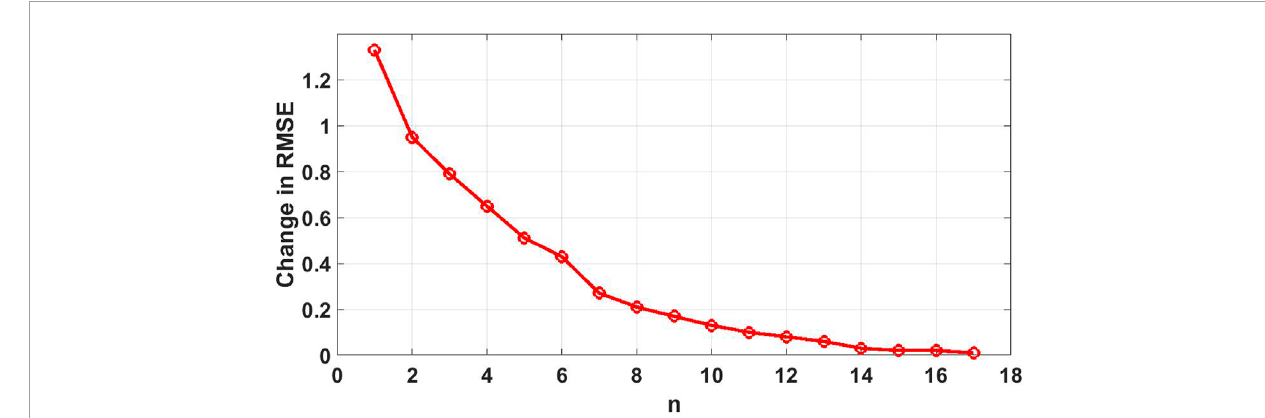
FIGURE 6 Change in RMSE for DNNwMF framework with the increase in n .